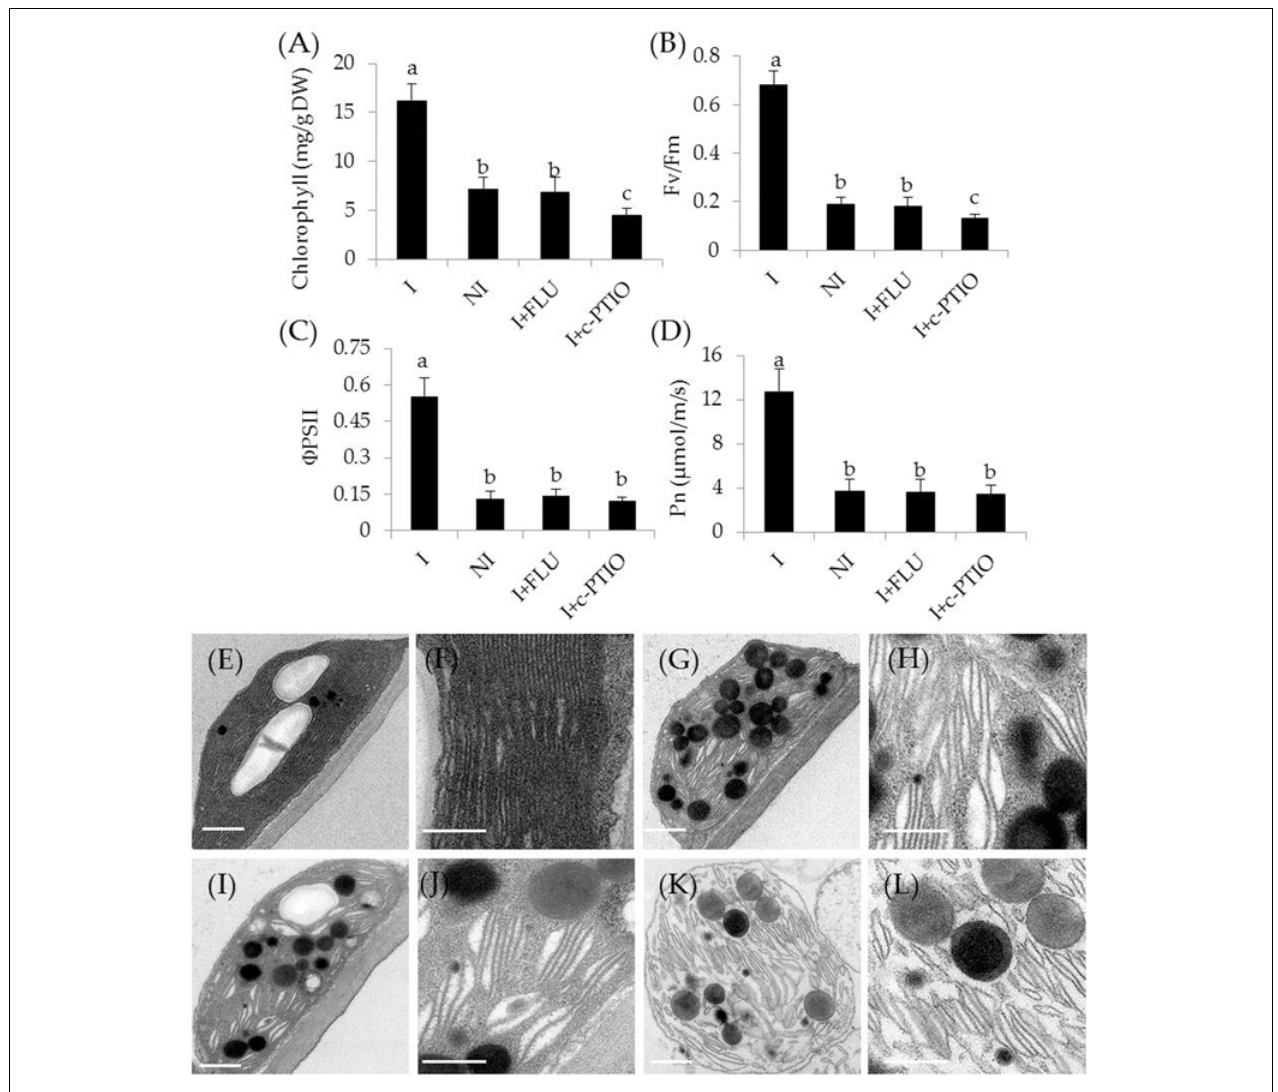
FIGURE 9 | Treatment with FLU or c-PTIO affected (A) total chlorophyll content, (B) F v/ F m, (C) (cid:56) PSII, and (D) Pn. In addition, chloroplast ultrastructure of the non-inoculated and inoculated plants: (E) the inoculated plants, (G) the non-inoculated plants, and (I) FLU- or (K) c-PTIO-treated inoculated plants. (F,H,J,L) Indicated locally amplified views in (E,G,I,K) , respectively. Scale bar = 1 µ m. Treatments and statistical analysis were as described in Figure 8